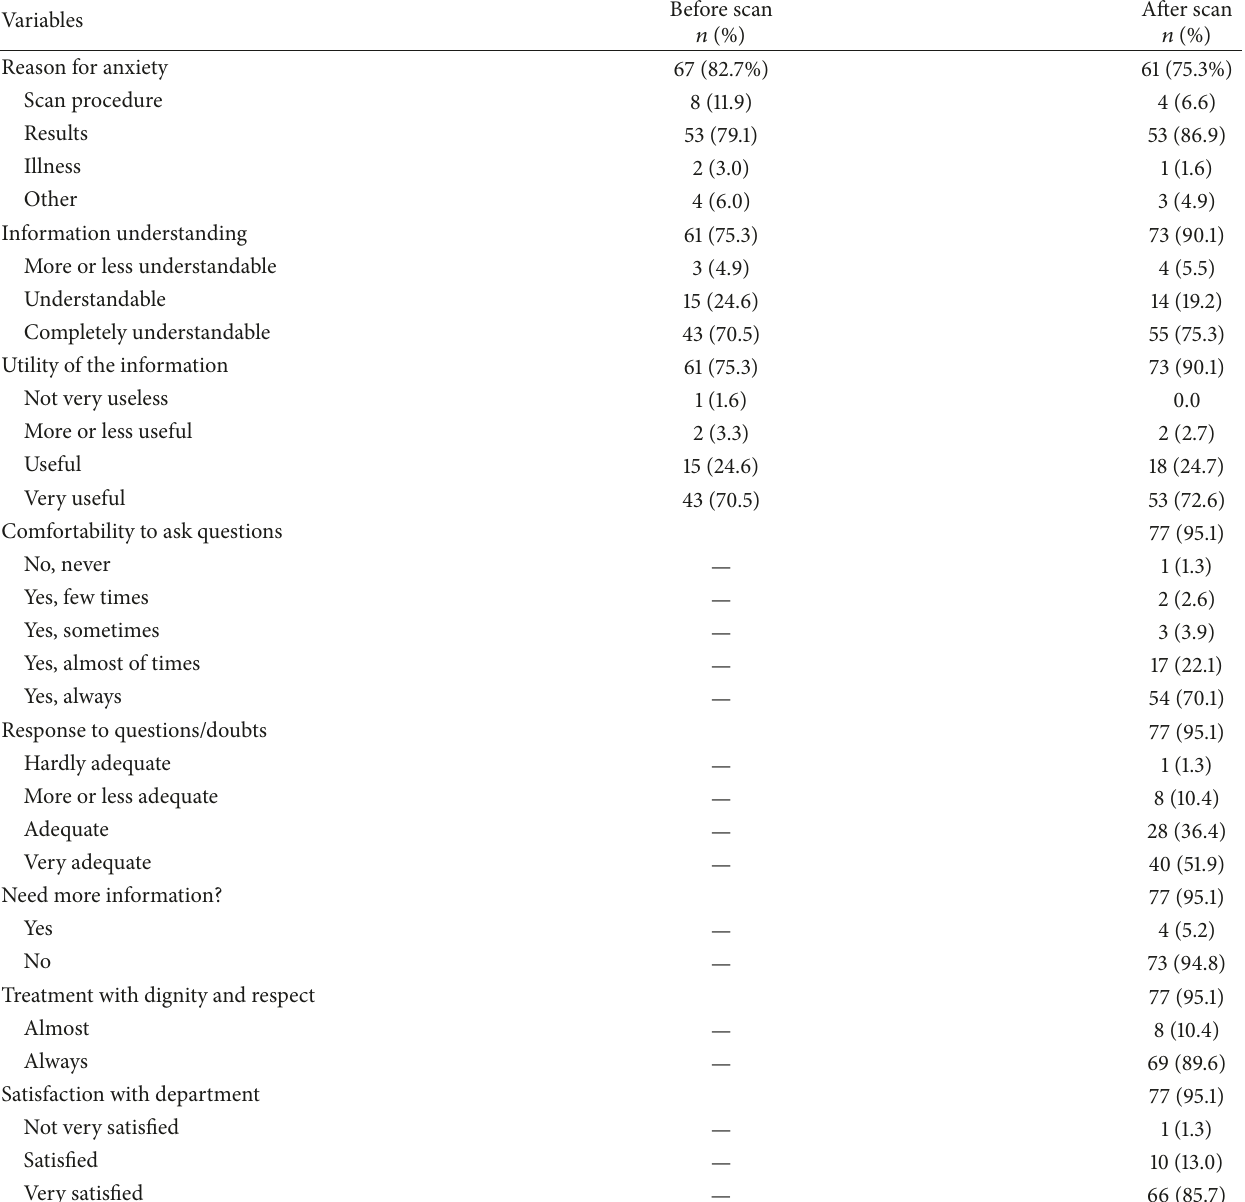
Table 2: Outcomes of SEQ before and after